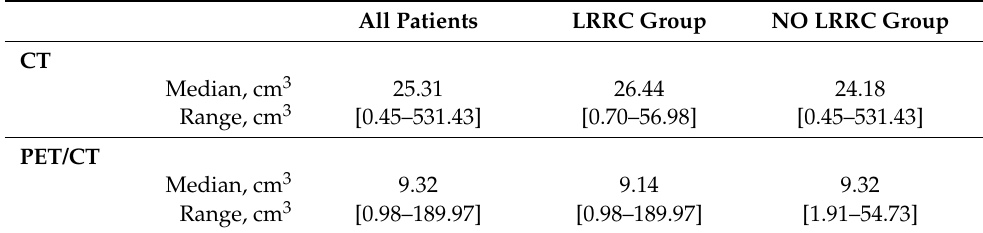
Table 2. ROIs’ size, in cm 3 , for both CT and PET/CT images, within LRRC and NO LRRC groups.